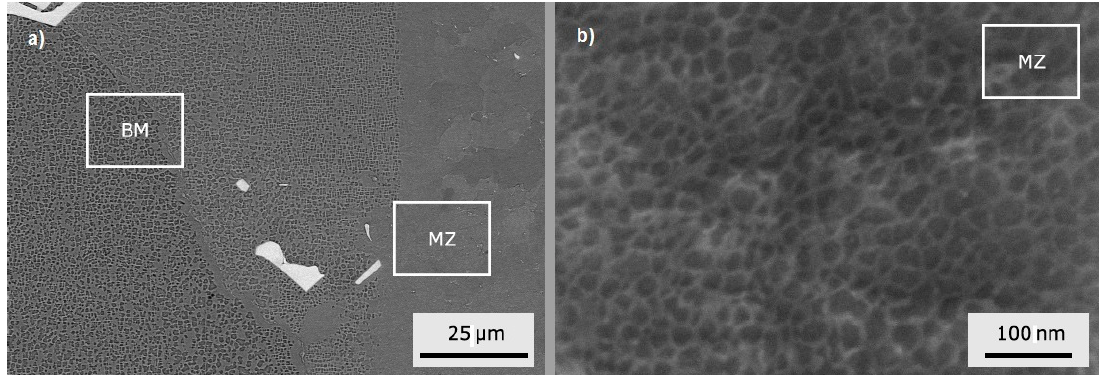
Figure 9. SEM observations of an EB joint (PHT = 300 °C and pass speed v = 2.5 m/min): ( a ) MZ microstructure (backscattered electrons imaging); ( b ) round γ ’ particles with size ranging from 20 to 40 nm are embedded in the equiaxed grains of MZ (secondary electron imaging).